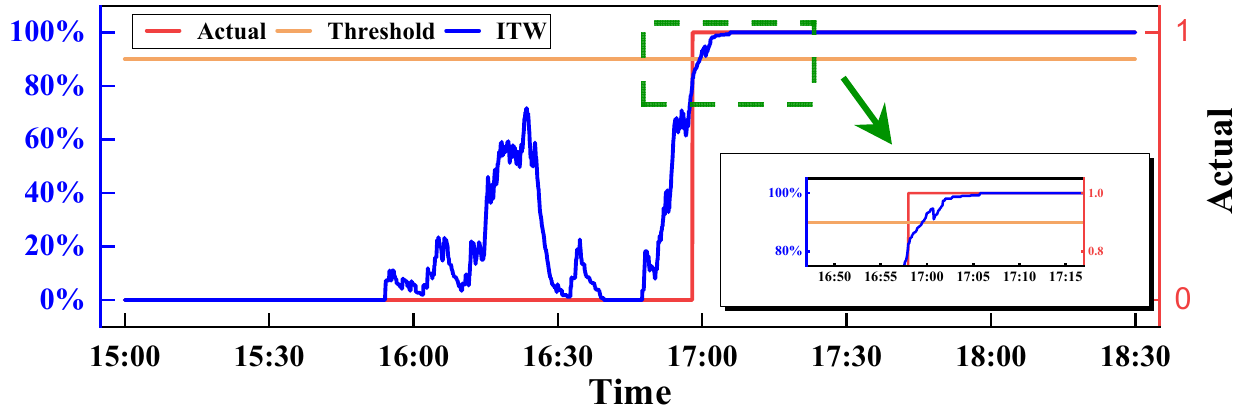
Figure 18. The FLI curve with the ITW.